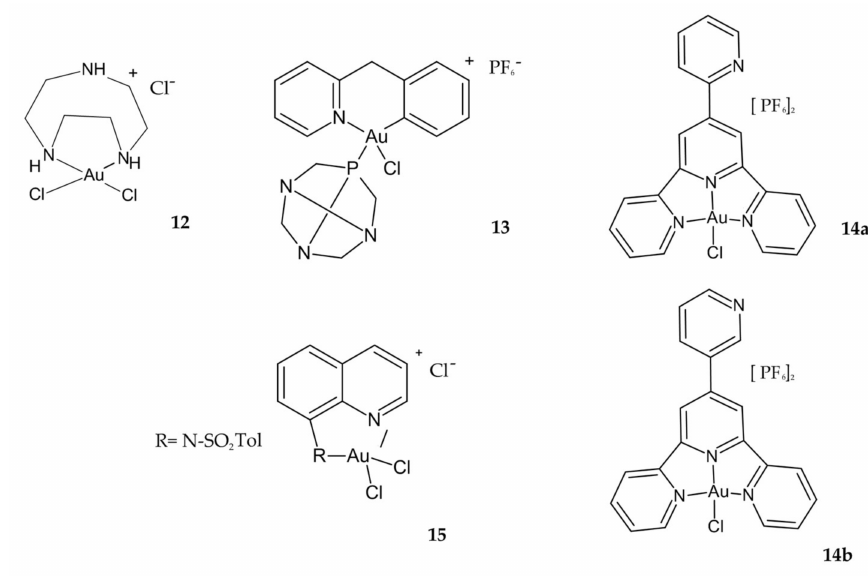
Figure 7. Au(III) complexes 12 , 13 , 14a,b , 15